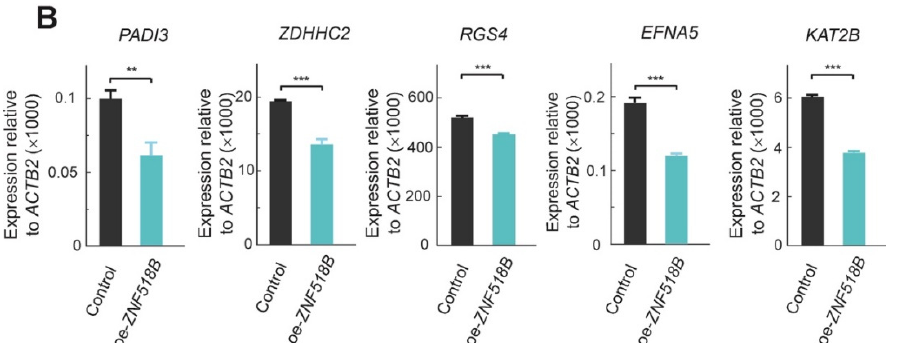
Figure 5. RT-qPCR validation of the changes in expression of the genes analysed for the binding of histone methyltrans- ferases. The figure shows that ZNF518B actually inhibits the expression of these genes . ( A ) Changes in expression in HCT116 cells caused by the knocking down of ZNF518B . ( B ) Changes in expression in RKO cells caused by overex- pressing ZNF518B . **, p < 0.01; ***, p < 0.001; NS, non-significant.